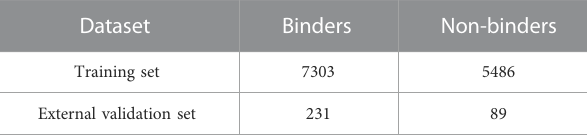
TABLE 1 Composition of the datasets used in this